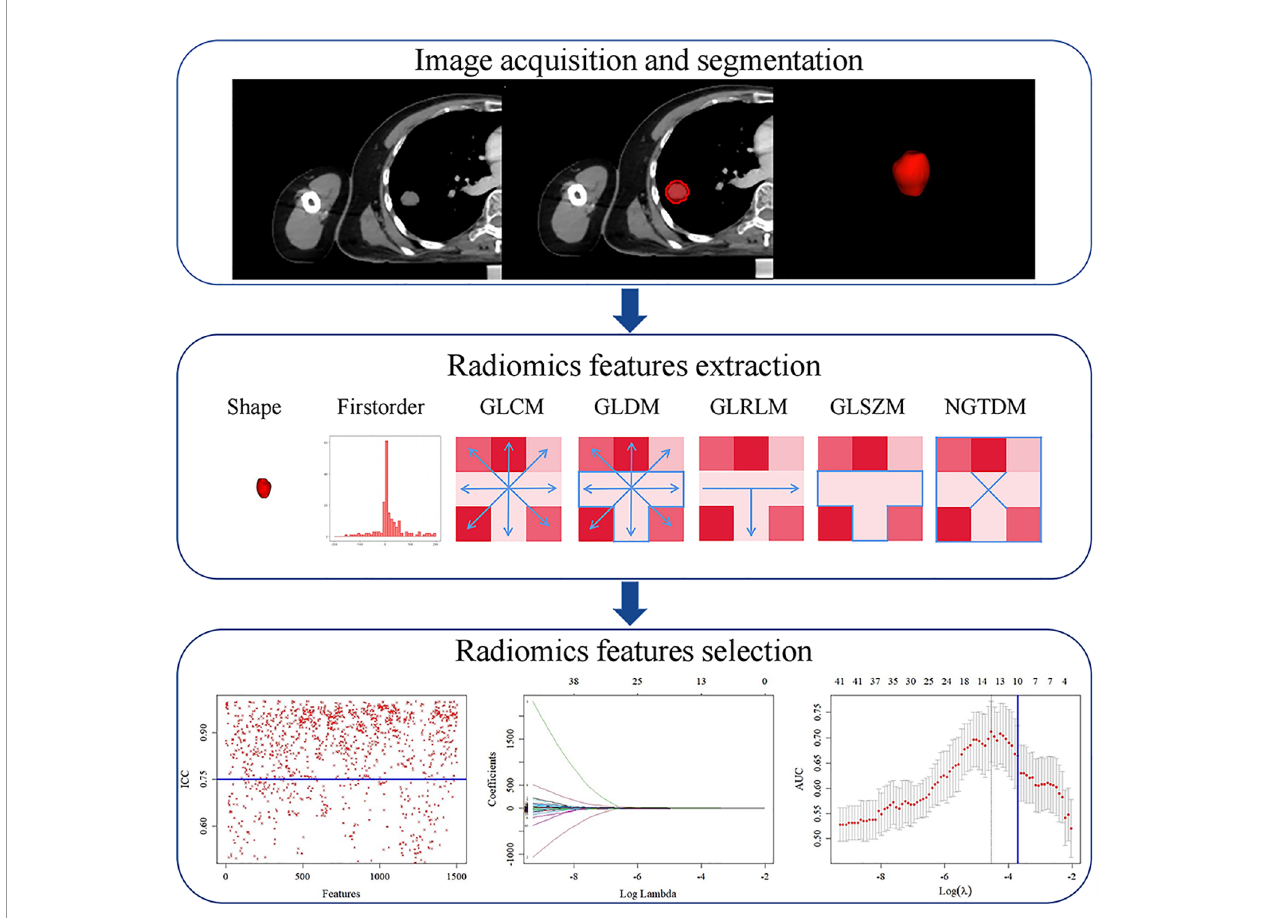
FIGURE 3 | Radiomics feature extraction and selection process. First, region of interest (ROI) segmentation was performed on CT image. Next, radiomics features were extracted from ROI. Finally, radiomics features dimension was reduced by intraclass correlation coef fi cient (ICC), least absolute shrinkage and selection operator (LASSO). GLCM, gray-level co-occurrence matrix; GLDM, gray-level dependence matrix; GLRLM, gray-level run length matrix; GLSZM, gray-level size zone matrix; NGTDM, neighborhood gray-tone difference